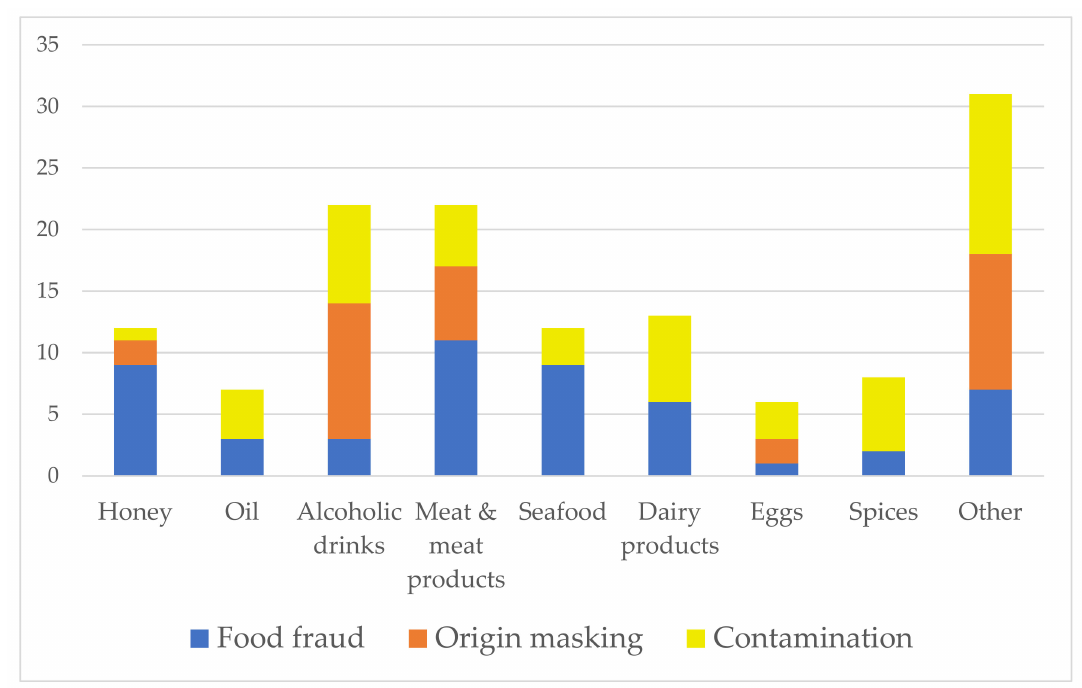
Figure 2. Food products that are most often subjected to unauthorized food manipulation (UFM) (2010–2020). Food fraud— mislabelling, deceiving practices, and ingredients replacement. Origin masking—food authenticity changed (counterfeiting). Contamination—harmful adulterant incorporated into food.